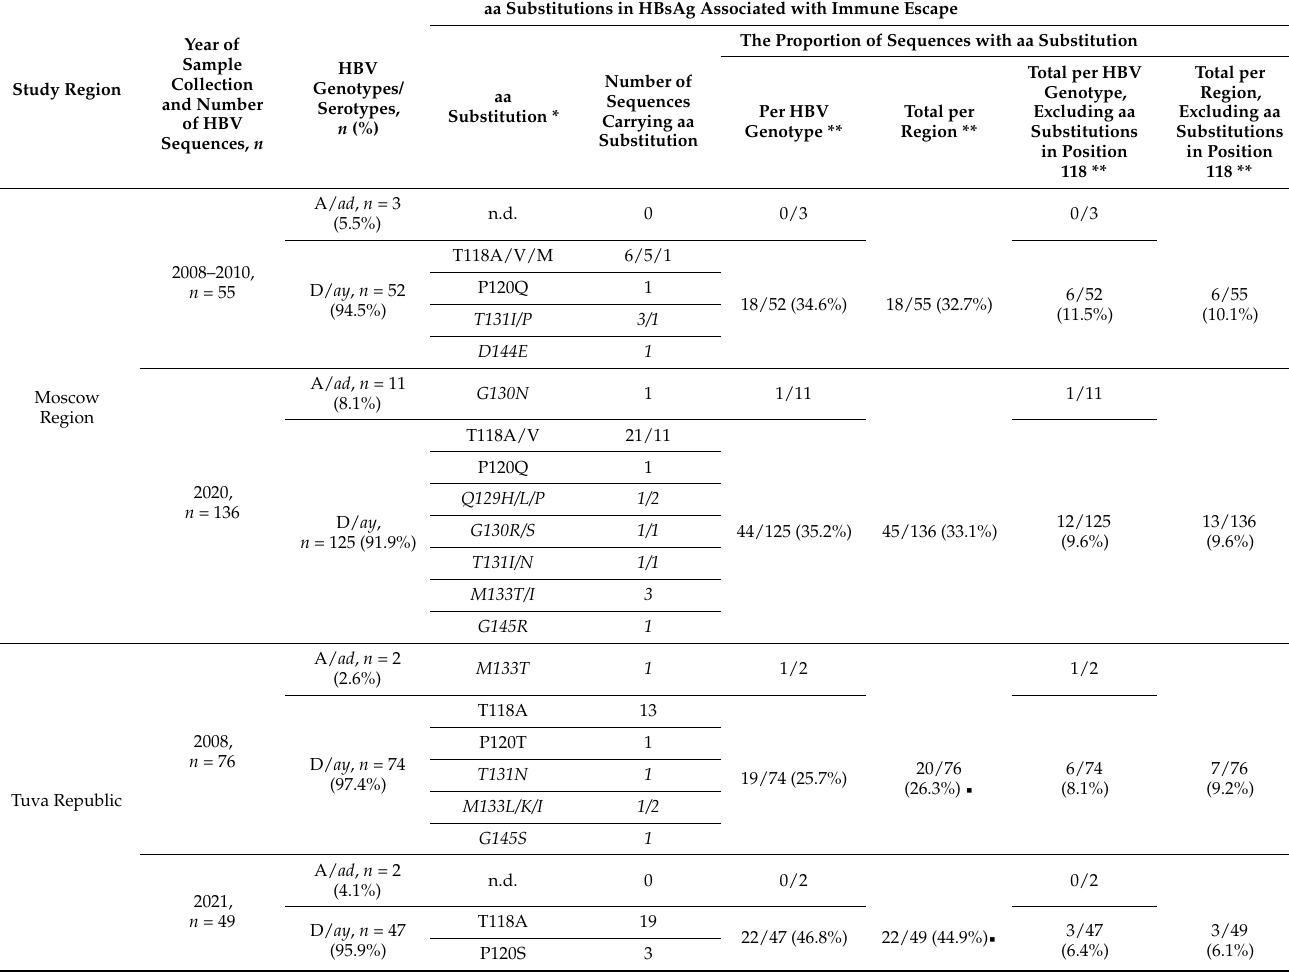
Table 2. Prevalence of HBV variants carrying amino acid substitutions in HBsAg in positions associated with immune